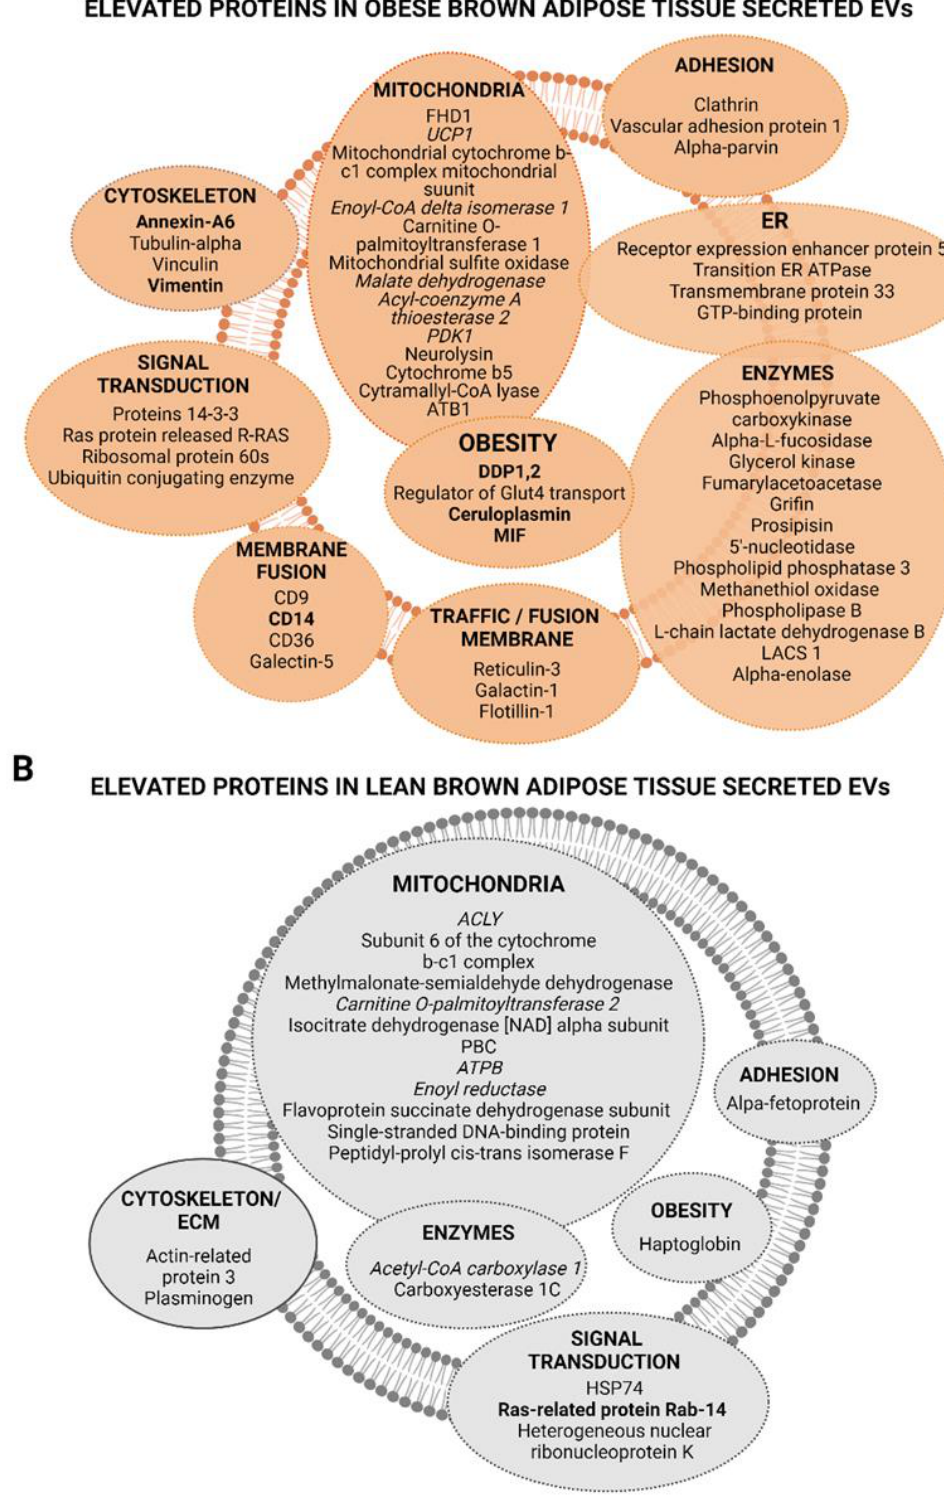
Figure 6. Proteome maps of upregulated proteins in brown adipose tissue (BAT) EVs (i.e., “batosomes”) from obese ( A ) and normal weight ( B ) animals with a fold change >1.5. Proteins in italics are related to beta-oxidation, and in bold to obesity and inflammation. ER, endoplasmic reticulum (Created with BioRender.com).